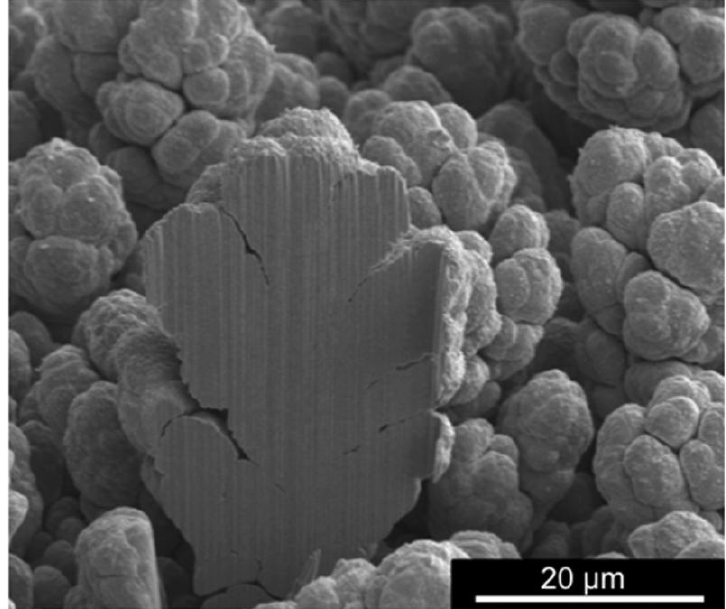
Figure 5. SEM image showing the cauliflower-like structure of Cu obtained by the two-step electrodeposition process. A focused ion beam was used to cut a cross-section to reveal the branches under the surface. Reprinted (adapted) with permission from [45]. Copyright 2014, American Chemical Society.